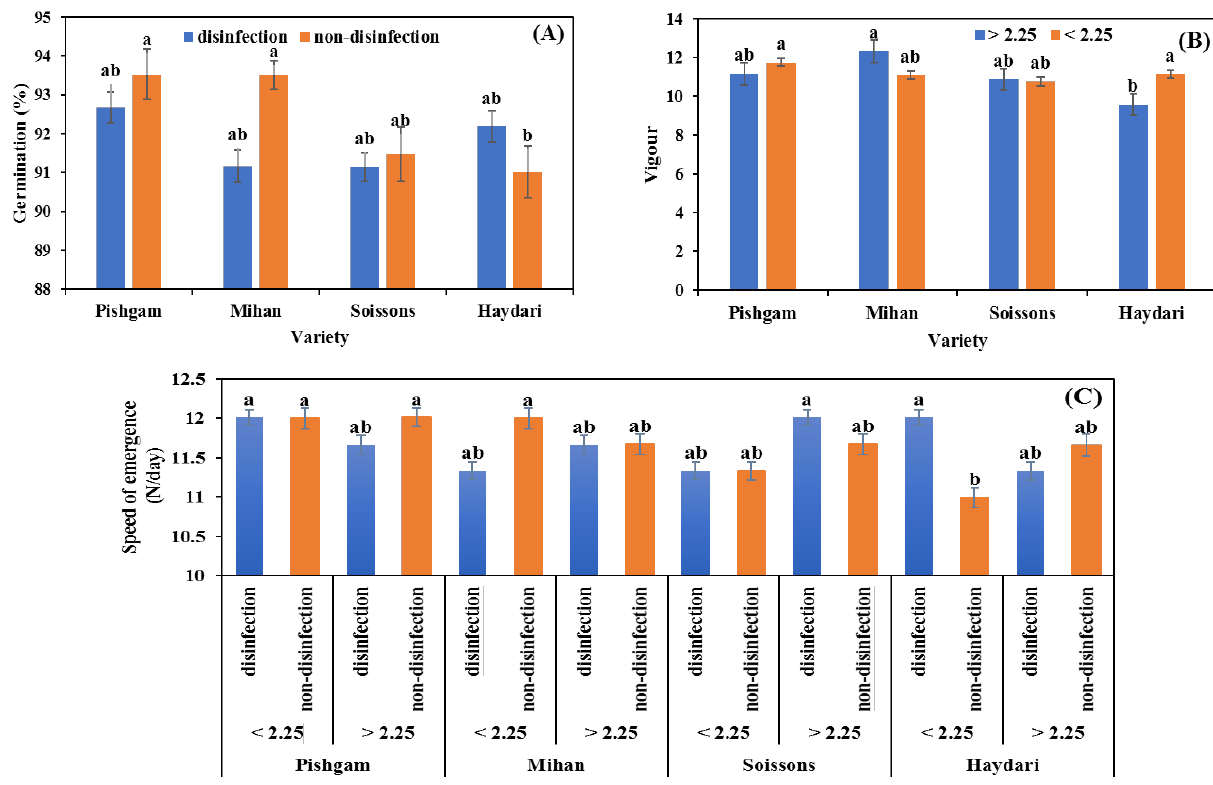
Figure 5. Effect of seed disinfection on GP ( A ), seed size on VI ( B ), and seed disinfection, seed size on SG ( C ) in different cultivars. The columns’ letters indicate the differences between the different treatments ( p < 0.05) using the LSD test.